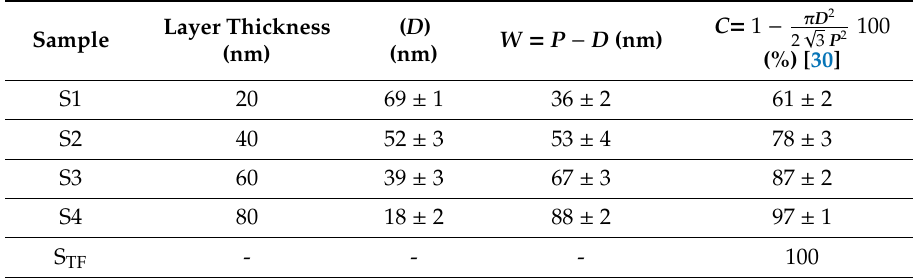
Figure 1. ( a – d ) SEM images of Fe 70 Pd 30 nanostructured film samples with different layer thicknesses: Table 2. The apparent geometrical parameters of Fe 70 Pd 30 nanostructured film samples were estimated from SEM images using Image J software [29], where D is the nanohole diameter, W is the edge-to-edge antidot distance and C is the magnetic surface coverage ratio percentage.